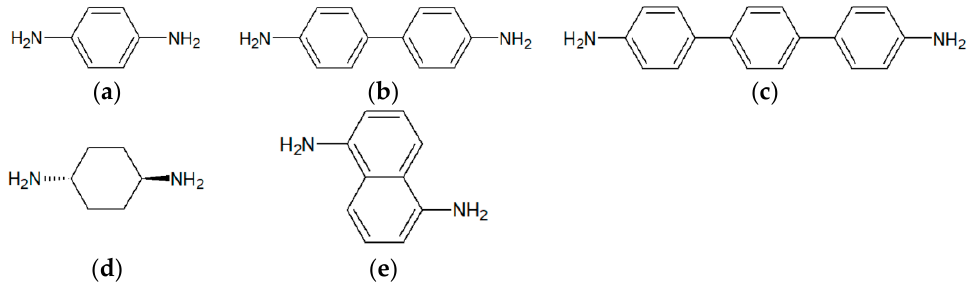
Figure 2. Chemical structures of bi-functional ligands: ( a ) p -phenylenediamine (PDA), ( b ) benzidine (BEN), ( c ) 4,4 ″ -diamino- p -terphenyl (DATER), ( d ) trans -1,4-diaminocyclohexane (DACH), ( e ) 1,5- diaminonaphthalene